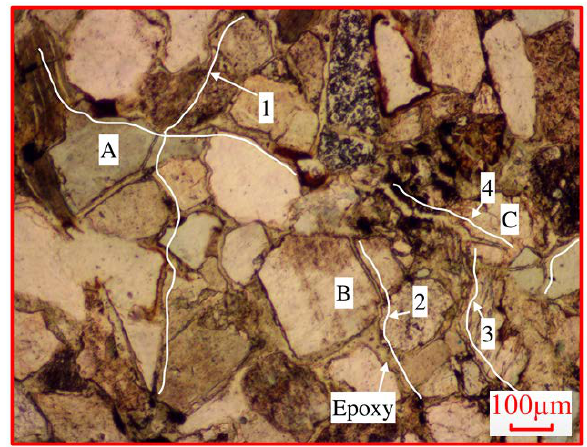
Figure 16. Transgranular cracks generated by closed intergranular cracks. Transgranular cracks (in grains A, B, and C) are generated by the extension of intergranular cracks (lines 1, 2, and 4). The numbers of white lines are marked as the number 1–4 in the white square.